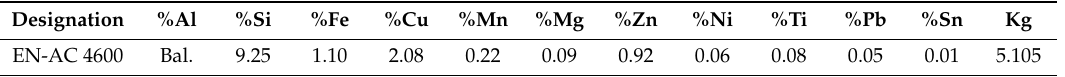
Table 1. Chemical components of AlSi series alloy.